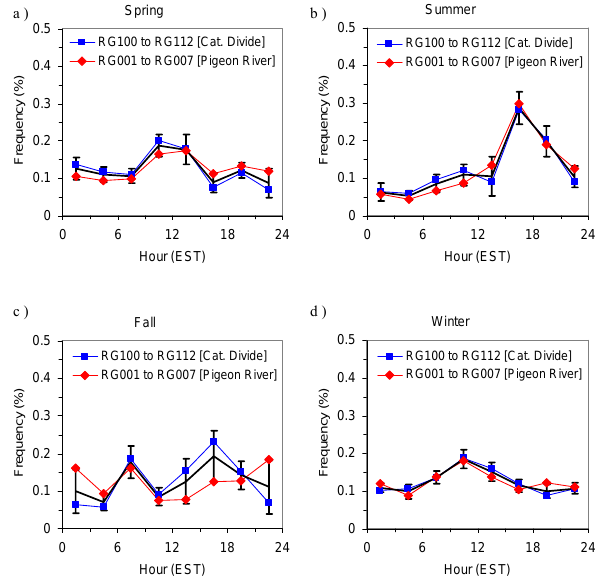
Fig. 3. Three-hourly diurnal cycle as a function of the meteorolog- Fig. 3: Three-hourly diurnal cycle as a function of the meteorological season of the year and the ical season of the year and the rain gauge network location (Pigeon rain gauge network location (Pigeon River basin and Cataloochee Divide): a) spring (March-April- River basin and Cataloochee Divide): (a) spring (Mar–Apr–May), May), b) summer (June-July-August), c) Fall (Sept-Oct-Nov), d) winter (Dec-Jan-Feb).